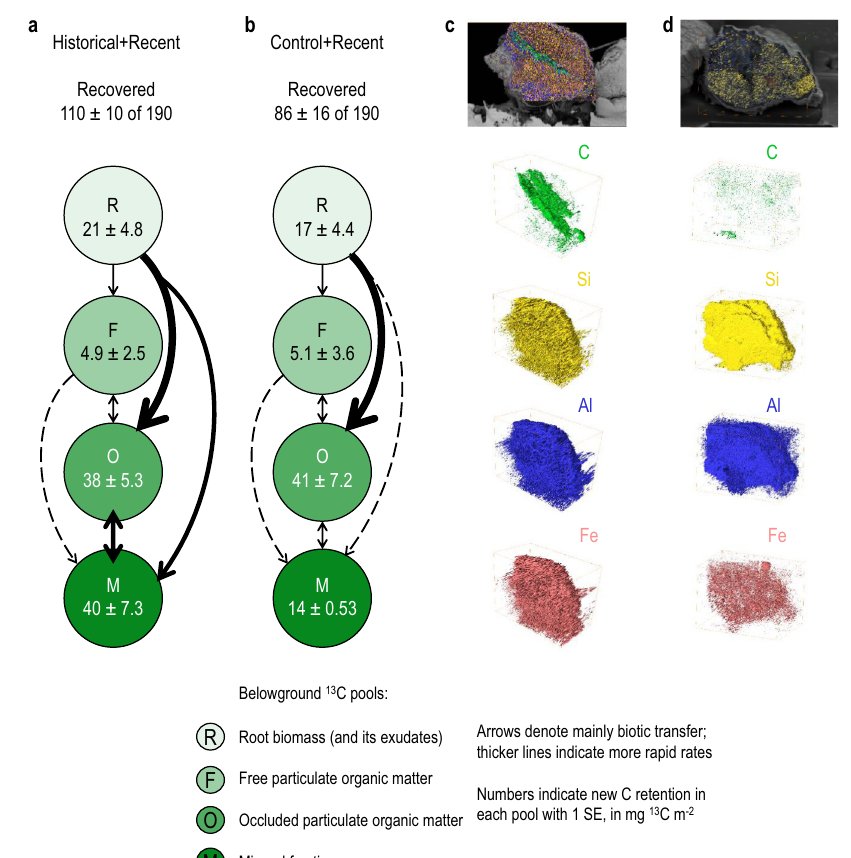
Fig. 3 | Allocation and retention of rhizodeposits ( 13 C-enriched) and three- dimensional (3D) elemental distribution in a biochar-amended Ferralsol at 9.5y. New C retention in different belowground carbon pools from Historical +Recent ( a ) and Control+Recent ( b ) soil ( n =3). The total recovery of 13 C from 13 C-CO 2 pulse labelling (± SE) is given for soil + root respiration, root biomass, free and occluded particulate matter, and mineral fractions 15 days after labelling each